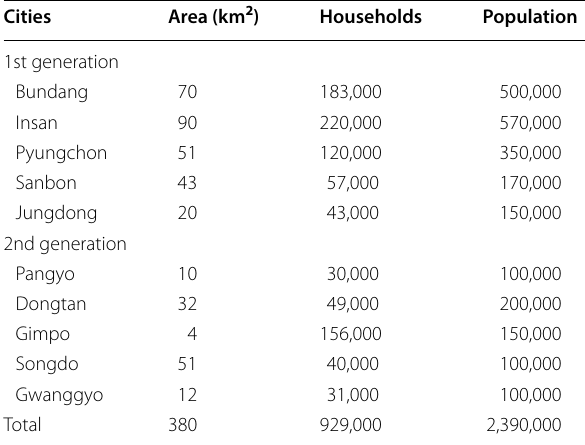
Table 6 New city implementation and its population